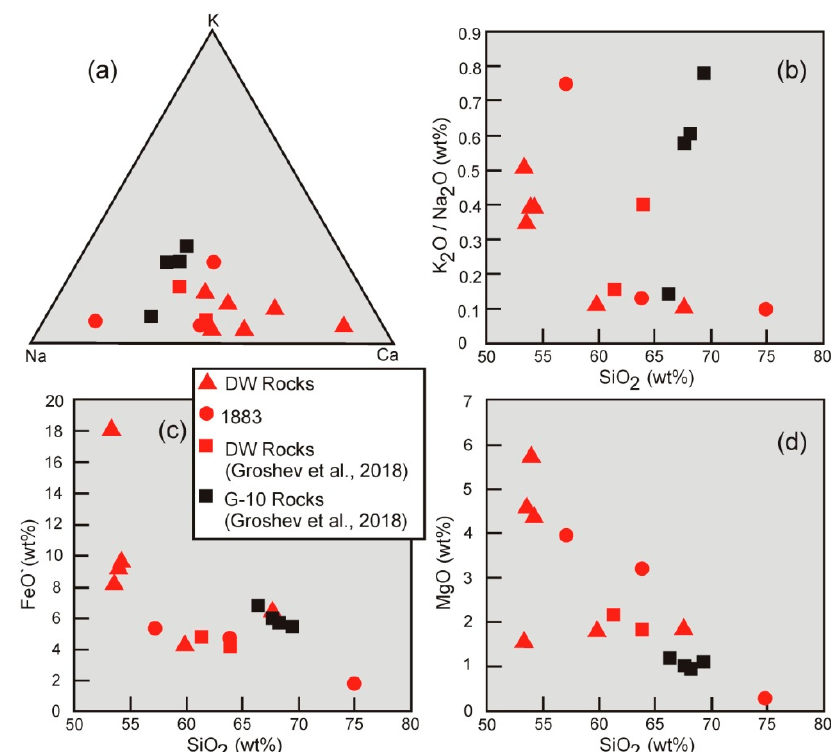
Figure 10. The rocks from the DW block, drill hole 1883, and the Gabbro-10 (G-10) massif in the triangular K-Na-Ca diagram ( a ) and binary diagrams ( b,c,d ).